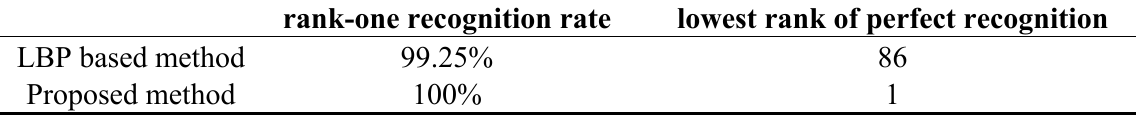
Table 5. Identification performance by different